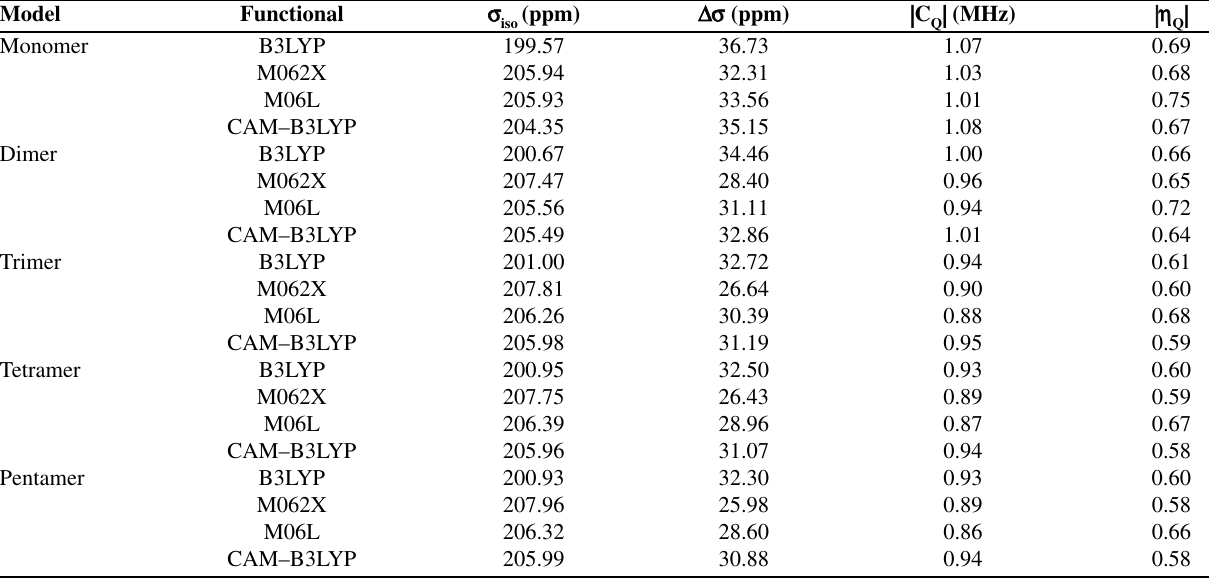
Table 4. Calculated nitrogen quadrupolar and chemical shift data for various threonine hydrochloride clusters. Model